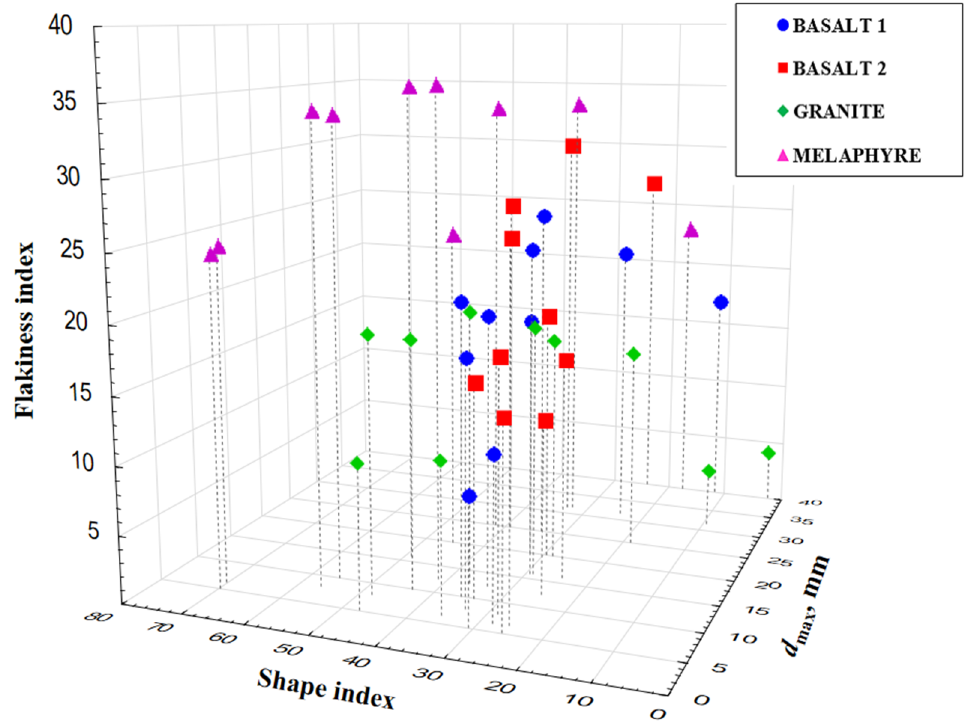
Figure 6. Comparison of shape and flakiness indexes for different size fractions.